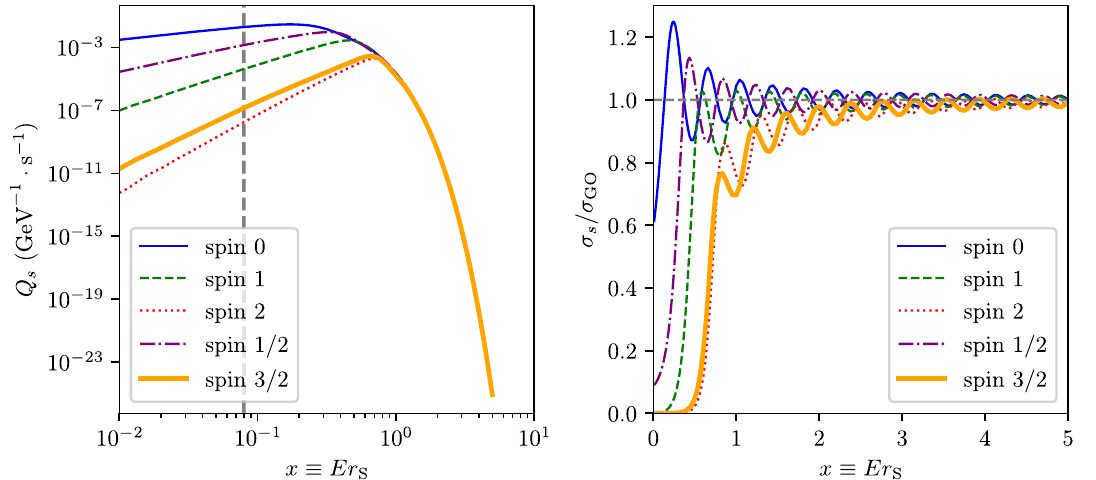
Fig. 1 Hawking spectra of massless particles of spins 0 (solid blue), 1 (dashed green), 2(dottedred)and1 / 2 (dot-dashed purple) aswellasthe new spectrum of the massless spin 3 / 2 fermion (thick solid orange) for a Schwarzschild BH. Left: Full spectra in logarithmic scale, the black